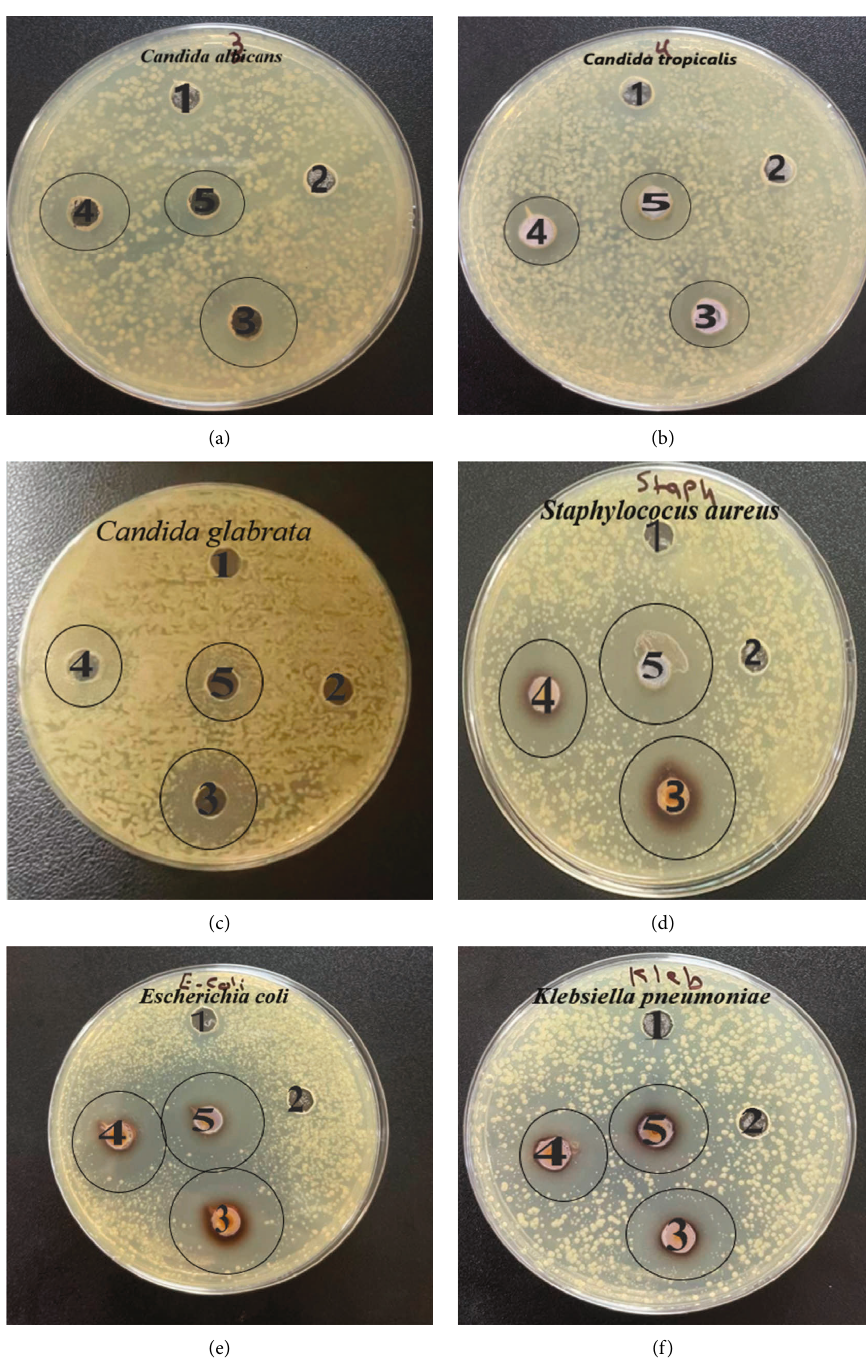
Figure 7: The antimicrobial activity assay against some pathogens. (a)–(c) Candida (yeasts). (d)–(f) Different bacteria, using the well diffusion method. (1) AgNO 3 . (2) Plant extract. (3) 1000 μ g/mL. (4) 800 μ g/mL. (5) 600 μ